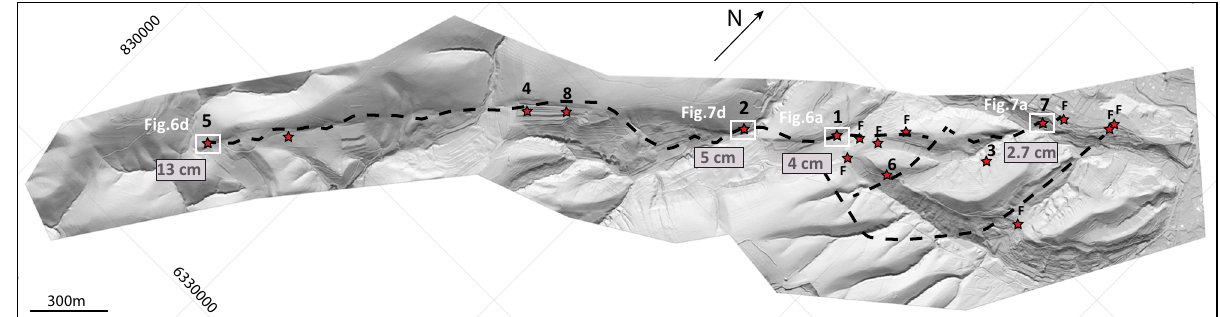
Fig. 8 Location of surface rupture observations (red stars) on a 25-cm-resolution shaded relief topographic map of the LRF fault scarp. The DEM is obtained from a post-earthquake airborne lidar survey (UTM grid). Numbers refer to main evidence described in the text (see Figs. 6 and 7 and Supplementary Figs. 2 and 3; vertical offset in rectangles), while “ F ” refers to open fi ssures affecting asphalt